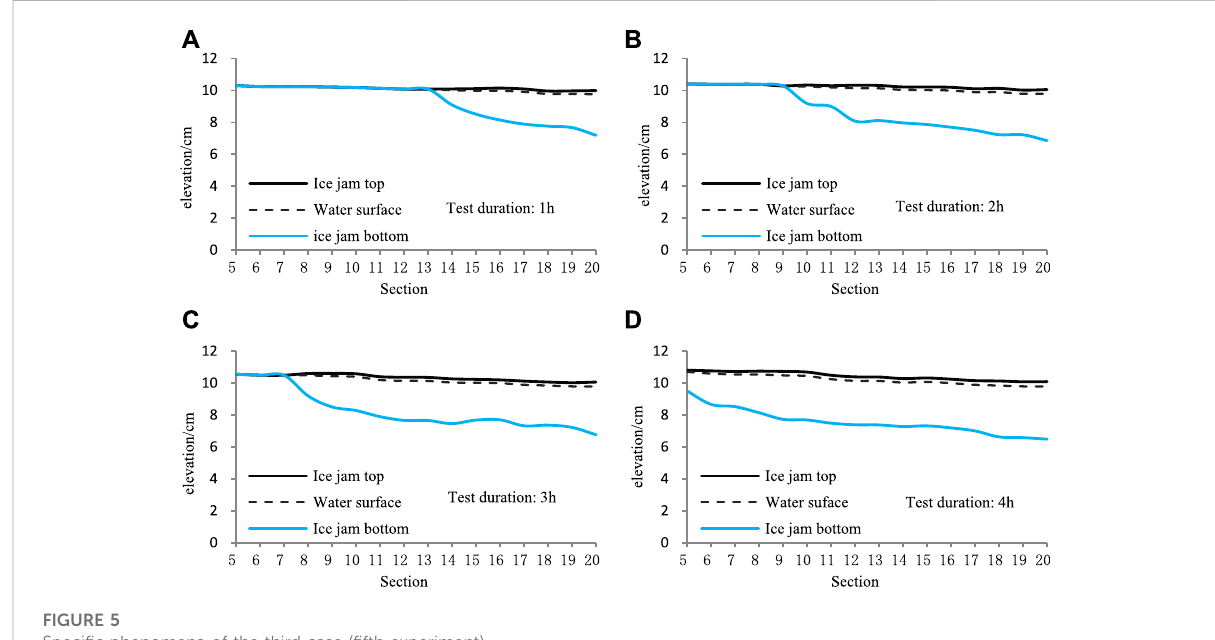
FIGURE 5 Speci fi c phenomena of the third case ( fi fth experiment).